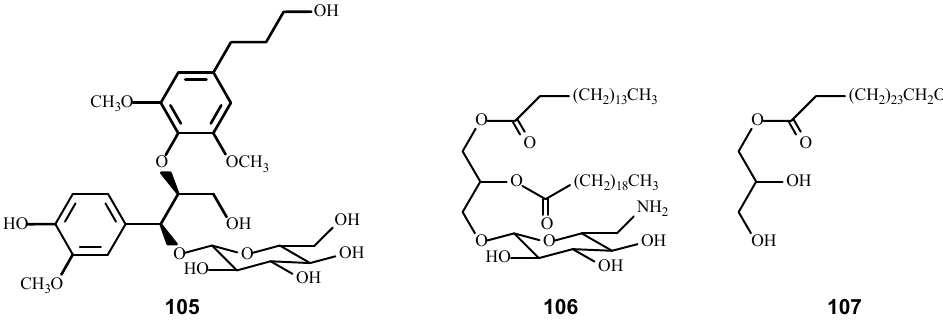
Figure 4. The chemical structures of compounds 89 – 107 .